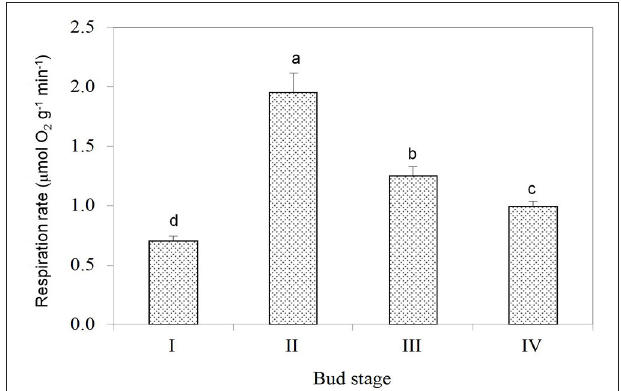
FIGURE 3 | Respiration rates of buds at different stages. Vertical bars represent standard errors of means. Different letters above columns indicate significant difference ( P < 0.05) between stages based on LSD multiple range tests ( n = 5).